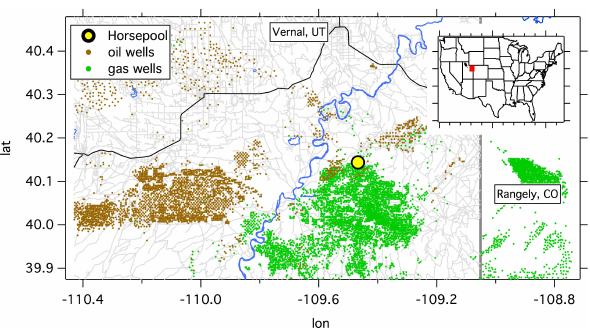
Figure 1. Map of the study area with the Horse Pool ground site in the Uintah Basin,